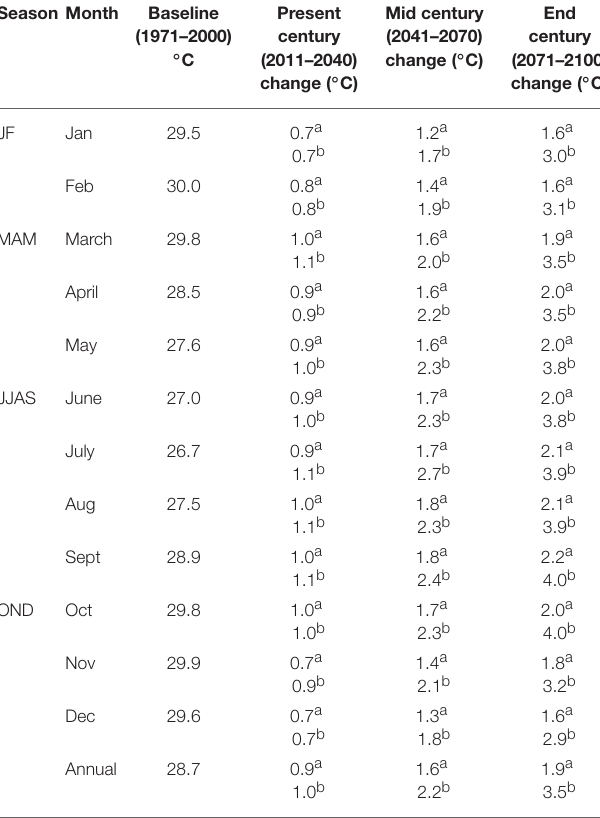
TABLE 5 | Projected change in rainfall over selected representative regions of Tanzania.